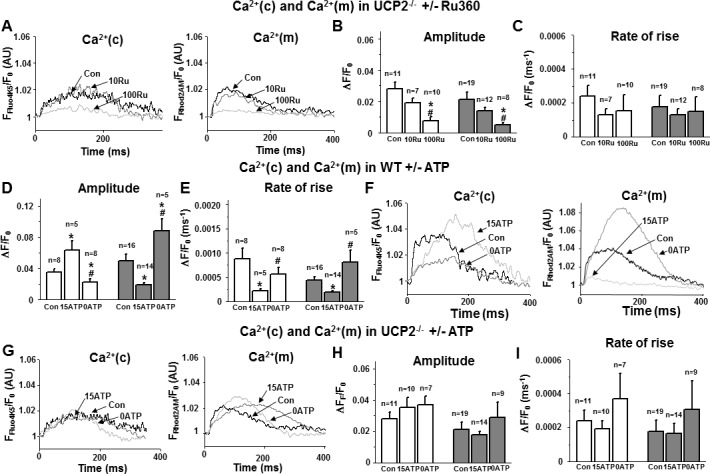
a-c) Ca2+ transients in UCP2-/- cardiomyocytes (UCP2) ± 10 and 100 nM Ru360. a) Representative traces of (Ca2+)c (left) and (Ca2+)m (right), and b-c) Statistical analysis: 10 nM Ru360 (10Ru) had no impact on either (Ca2+)c or (Ca2+)m transient amplitudes of UCP2-/- cardiomyocytes. 100 nM Ru360 (100Ru) significantly decreased the amplitude in both compartments without affecting the rate of rise. *p<0.05 vs. Con; #p<0.05 vs. Con + 10 nM Ru360. d-f) Ca2+ transients in WT cardiomyocytes + 5 (Con), + 0 (0ATP) and + 15 mM ATP (15ATP). d-e) Statistical analysis, and f) representative traces of (Ca2+)c (left) and (Ca2+)m (right): In the absence of ATP the amplitude of (Ca2+)m was significantly increased, while it was suppressed when ATP was elevated to 15 mM. Conversely, the amplitude of (Ca2+)c was significantly decreased in the absence of ATP and significantly increased with 15 mM ATP. The rate of rise of (Ca2+)m and (Ca2+)c was significantly decreased in the presence of 15 mM ATP. This inhibitory effect of ATP suggests a similar shift of dyadic cleft Ca2+ towards the ryanodine receptor (RyR) as in WT cardiomyocytes ± Ru360. The opposite effect was observed in the absence of ATP. *p<0.05 vs. Con; #p<0.05 vs. 15 mM ATP. g-i) Ca2+ transients in UCP2-/- cardiomyocytes + 5 (Con), + 0 (0ATP) and + 15 mM ATP (15ATP). g) Representative traces of (Ca2+)c (left) and (Ca2+)m (right), and h-i) statistical analysis: The modulation of the ATP concentration had no significant impact on either amplitude or rate of rise of Ca2+ in both cellular compartments.